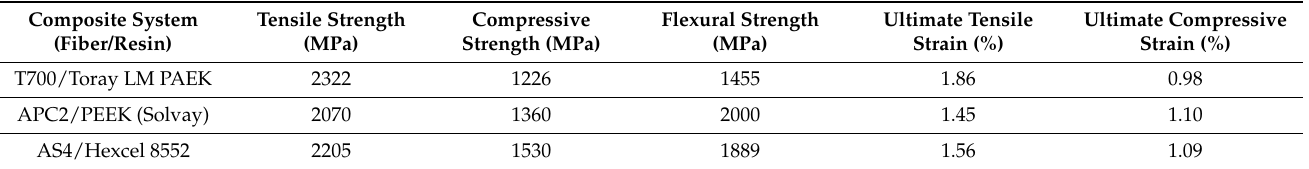
Table 2. Strengths and strains of three selected CFRP systems.